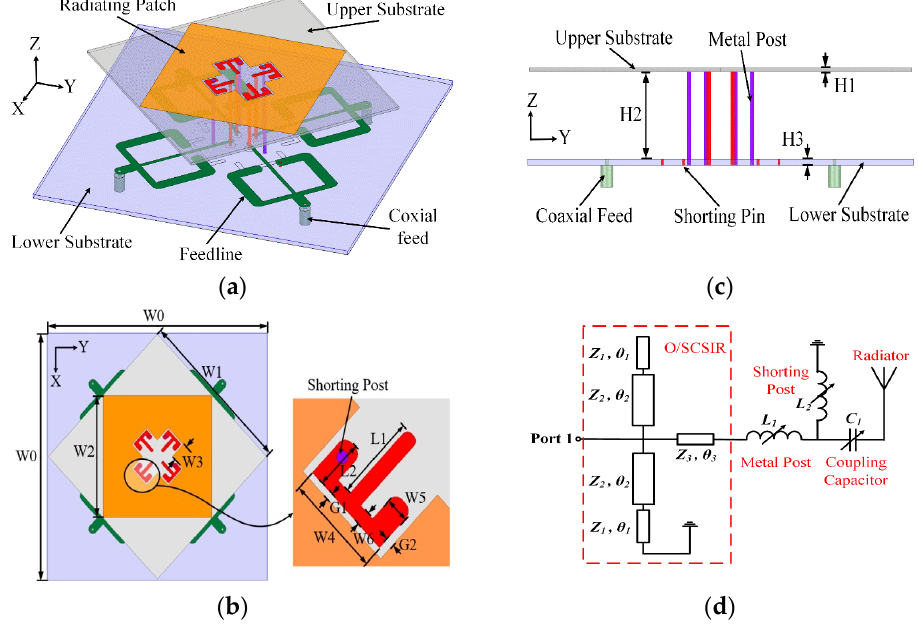
Figure 14. Antenna configuration: ( a ) 3D view, ( b ) top view, ( c ) front view, ( d ) Equivalent circuit [39].